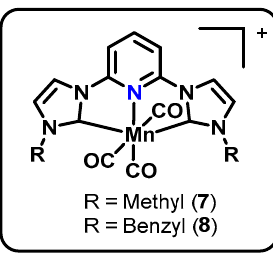
Figure 4. Structures of complexes 7 ([MnCNC Me (CO) 3 ]Br) and 8 ([MnCNC Bn (CO) 3 ]Br).